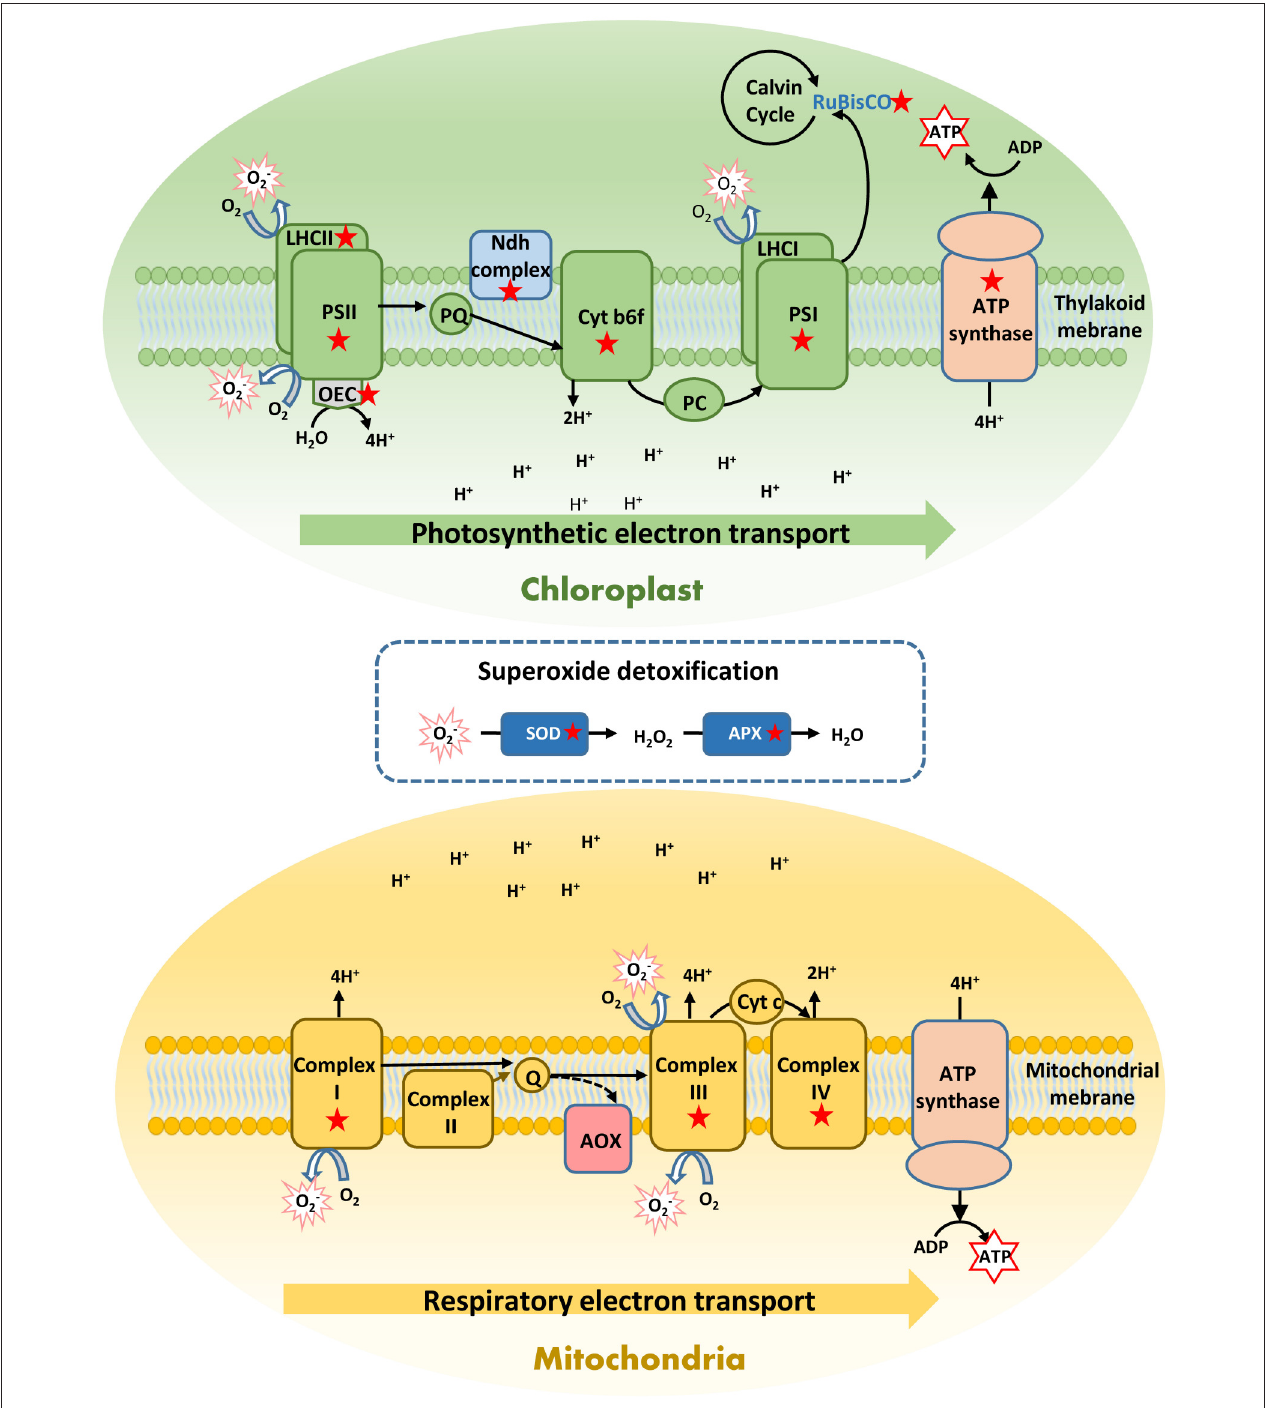
FIGURE 6 | Schematic representation of a respiratory and photosynthetic electron transport chains (ETC) showing the components in which heat-induced genes in shallow Posidonia oceanica plants are involved (labeled with a red star). Heating induced over-expression of a rich set of photosynthetic genes to improve the turnover of functional and structural proteins and maintain an efficient photosythetic performance and ATP production. In addition, heat stress uniquely induced in shallow plants over-expression of respiratory genes related to the mitochondrial ETC complexes I, III, and IV, which reflect the activation of the cytochrome pathway for respiratory ATP production. Although this pathway is more energy-efficient than the alternative oxidase pathway (AOX), it is also the main producer of mitochondrial ROS, especially the superoxide radical (O − 2 ). To protect against oxidative damage these shallow plants activated the ROS-scavenging enzymes superoxide dismutase (SOD) and ascorbate peroxidase (APX). These exclusive responses of shallow plants conferred them higher heat tolerance respect to deep plants, and enabled them for an efficient energy production to cover the energetic cost associate to heat stress. A complete list of these genes with their corresponding fold change is shown in Figure 5 and in Data S1.